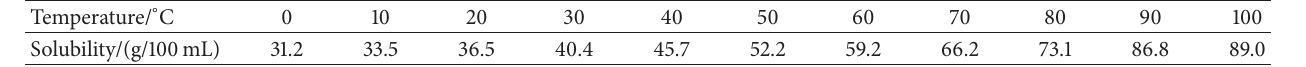
Table 5: Aluminum sulfate octadecahydrate solubility.